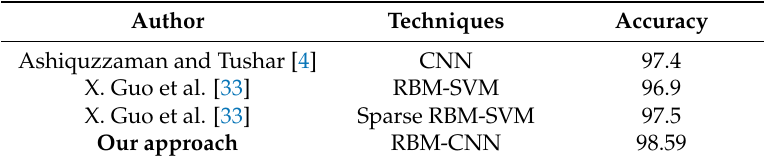
Table 5. Performance comparison of the proposed and related methods described in [4,33].